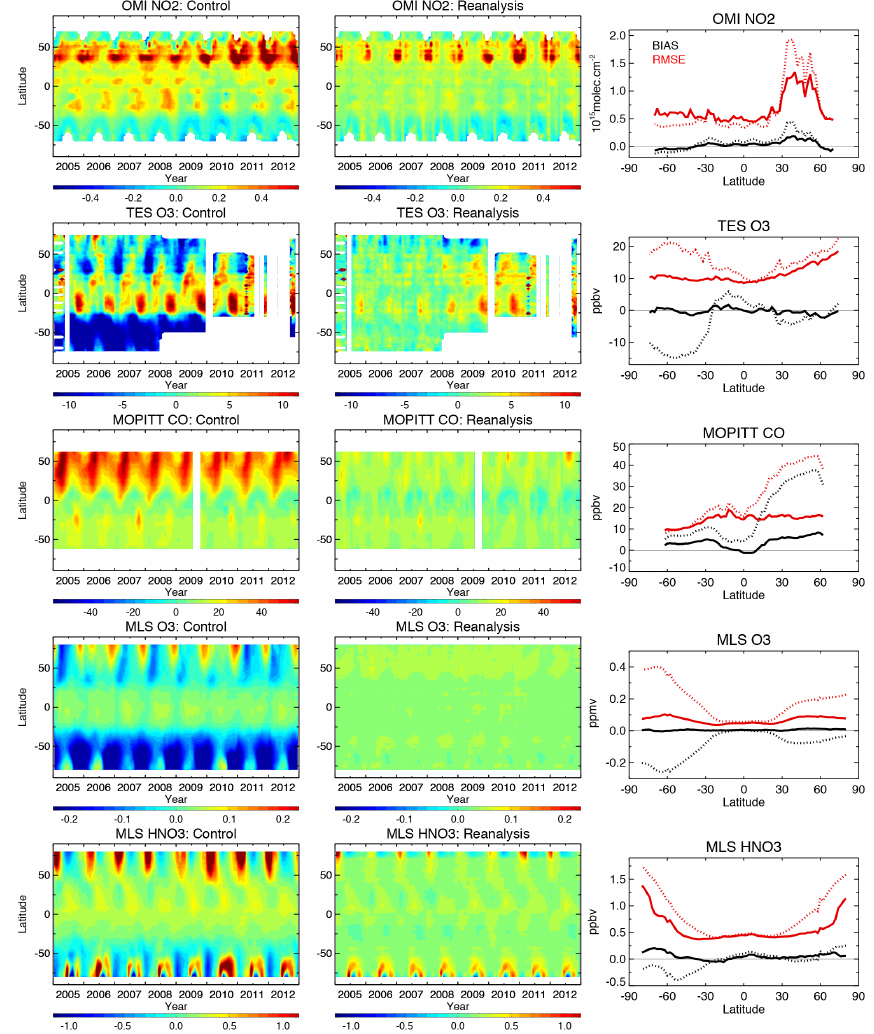
Figure 2. Time–latitude cross section of the monthly and zonal mean OmF obtained without assimilation (left panels) and with assimilation (centre panels). The positive and negative OmF values are shown in red and blue, respectively. Positive OmF represents negative model bias compared with observations. Right panels show latitudinal distributions of the 8-year mean OmF bias (black line) and RMSE (red line) ob- tained with assimilation (solid line) and without assimilation (dotted line). The first row is the OmF for OMI NO 2 data (in 10 15 moleccm − 2 ), second row is for TES O 3 data between 500 and 300hPa (in ppb), third row is for MOPITT CO data between 700 and 500hPa (in ppb), fourth row is for MLS O 3 data between 216 and 100hPa (in ppm), and fifth row is for MLS HNO 3 data between 150 and 80hPa (in ppb). A super-observation approach is employed to the OMI and MOPITT measurements, whereas individual observations are used in the analysis of the